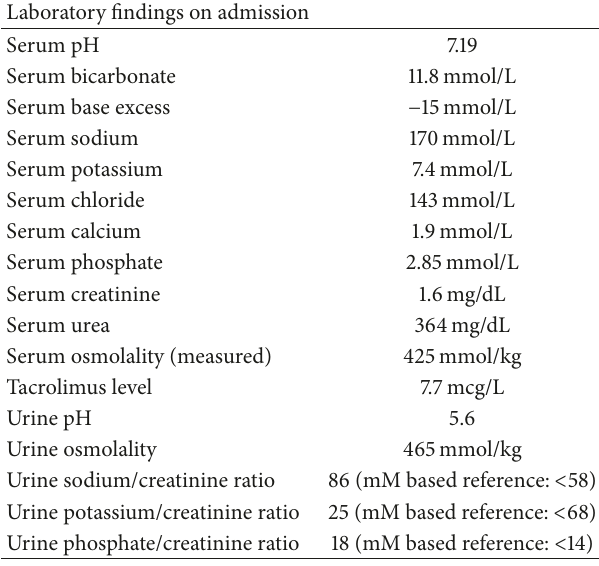
Table 1: Laboratory findings on admission to the pediatric intensive care unit.